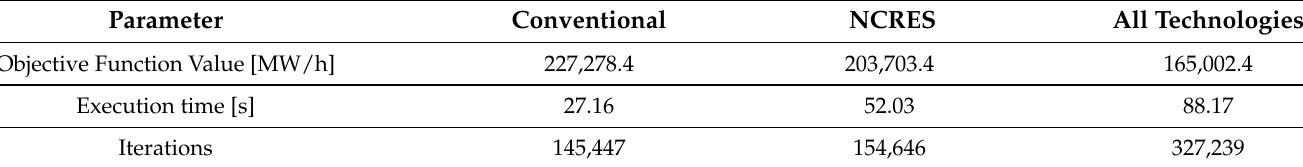
Table 6. Objective function of the restoration process with and without NCRES and